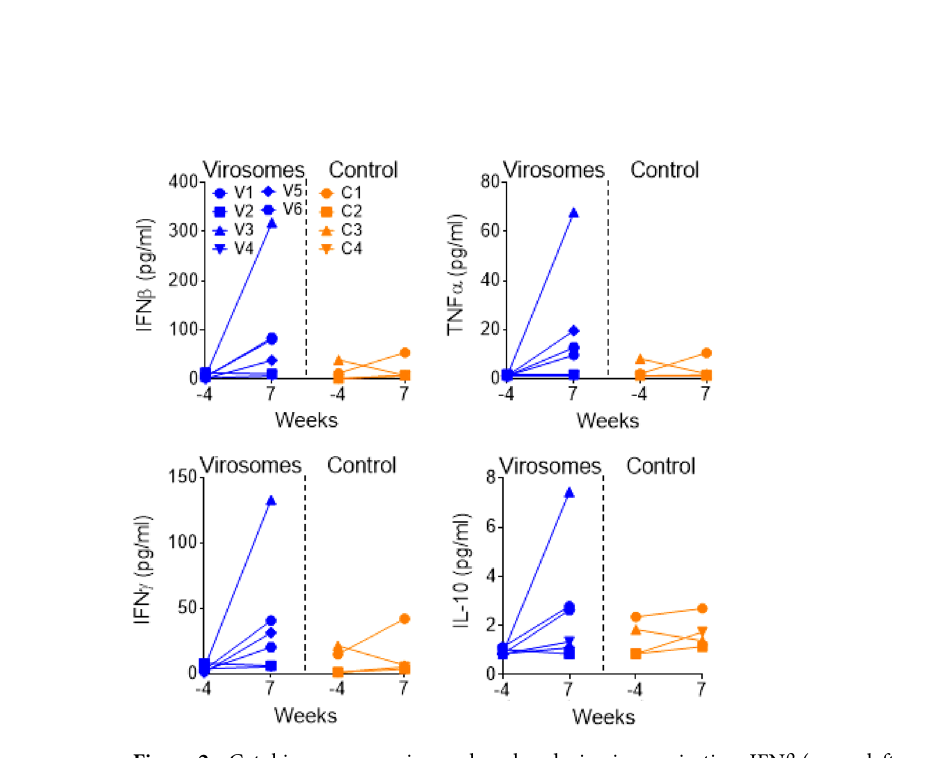
Figure 2. Cytokine responses in nasal washes during immunization. IFNβ (upper left panel), TNFα (upper right panel), IFNγ (lower left panel) and IL-10 (lower right panel) cytokine levels (pg/mL) measured in nasal washes, either before immunization (week -4) or three weeks after the second immunization (week 7). Macaques immunized with virosomes-RBD (V1 to V6 in blue) and control animals (C1 to C4 in orange). Each animal is represented by a different symbol. For the serum, week -4 versus week 7 (21 days after last immunization), the vaccinated group is not significantly different from the control group for IFNβ, TNFα, IFNγ and IL-10 (Mann– Whitney test). However, there is a significant increase of cytokines in nasal washes of virosome vaccinated animals (week-4 versus week 7, Mann–Whitney test) for IFNβ ( p = 0.087), TNFα ( p = 0.013), IFNγ ( p = 0.087), and IL-10 ( p = 0.433), while these increases are not observed in control